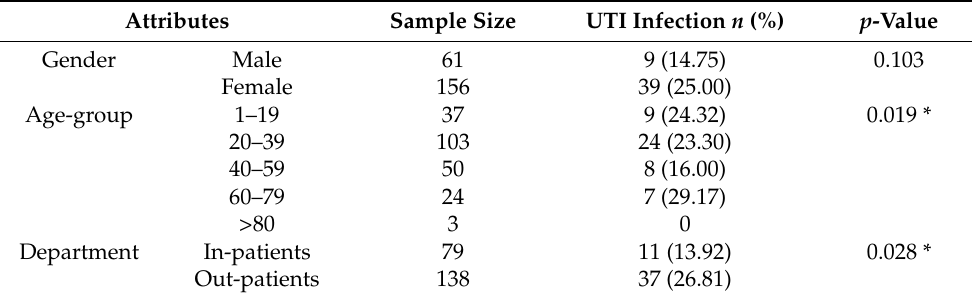
Table 3. Association of UTIs with respect to various